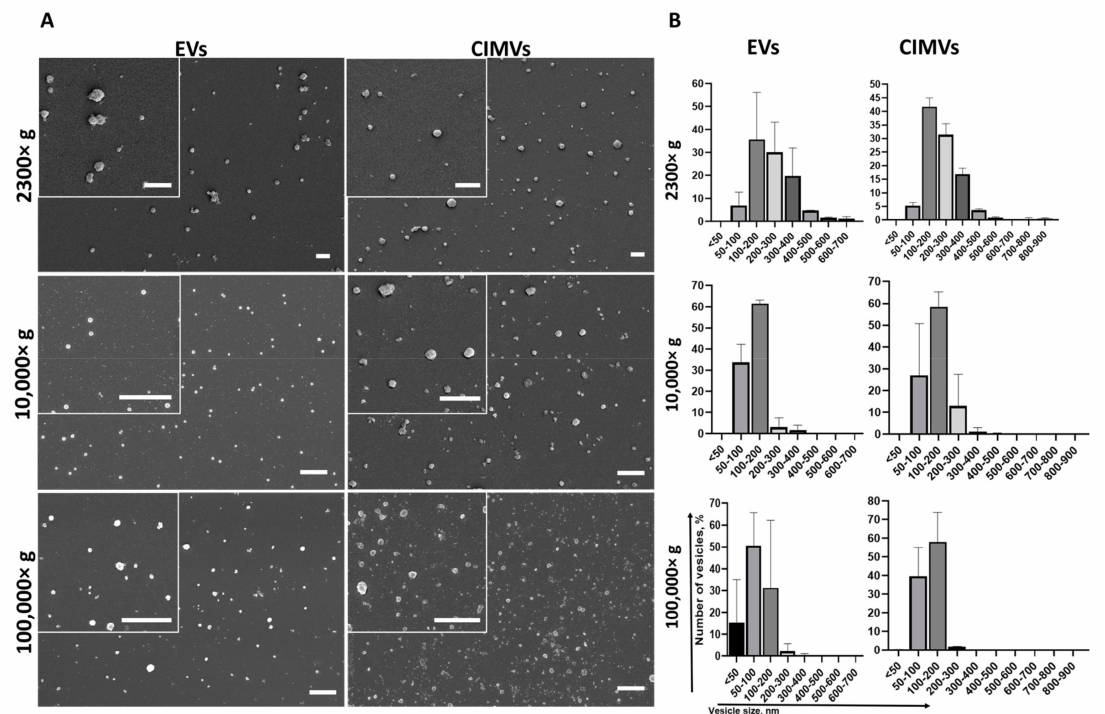
Figure 2. Analysis of morphology ( A ) and size distribution ( B ) of vesicles obtained during EVs and CIMVs isolation after centrifugation 2300 × g , 10,000 × g , and 100,000 × g . Scale bar—1 µ